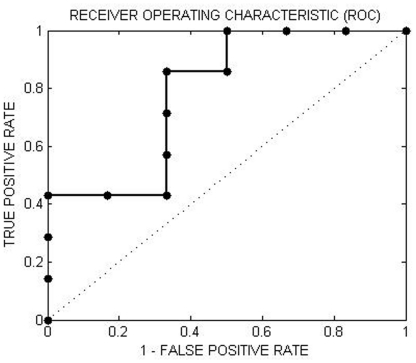
We used the predictive probabilities from the classifier at-risk adolescents vs. controls as a score for the at-risk adolescents.An ROC curve was used to evaluate if this score could be used to predict which of at-risk adolescents developed a future mood disorder. Each point on the ROC curve represents a sensitivity/specificity pair corresponding to a particular decision threshold. A test with perfect discrimination has a ROC curve that passes through the upper left corner (100% sensitivity, 100% specificity). The area under the ROC curve (AUC) was 0.78 (p<0.05).